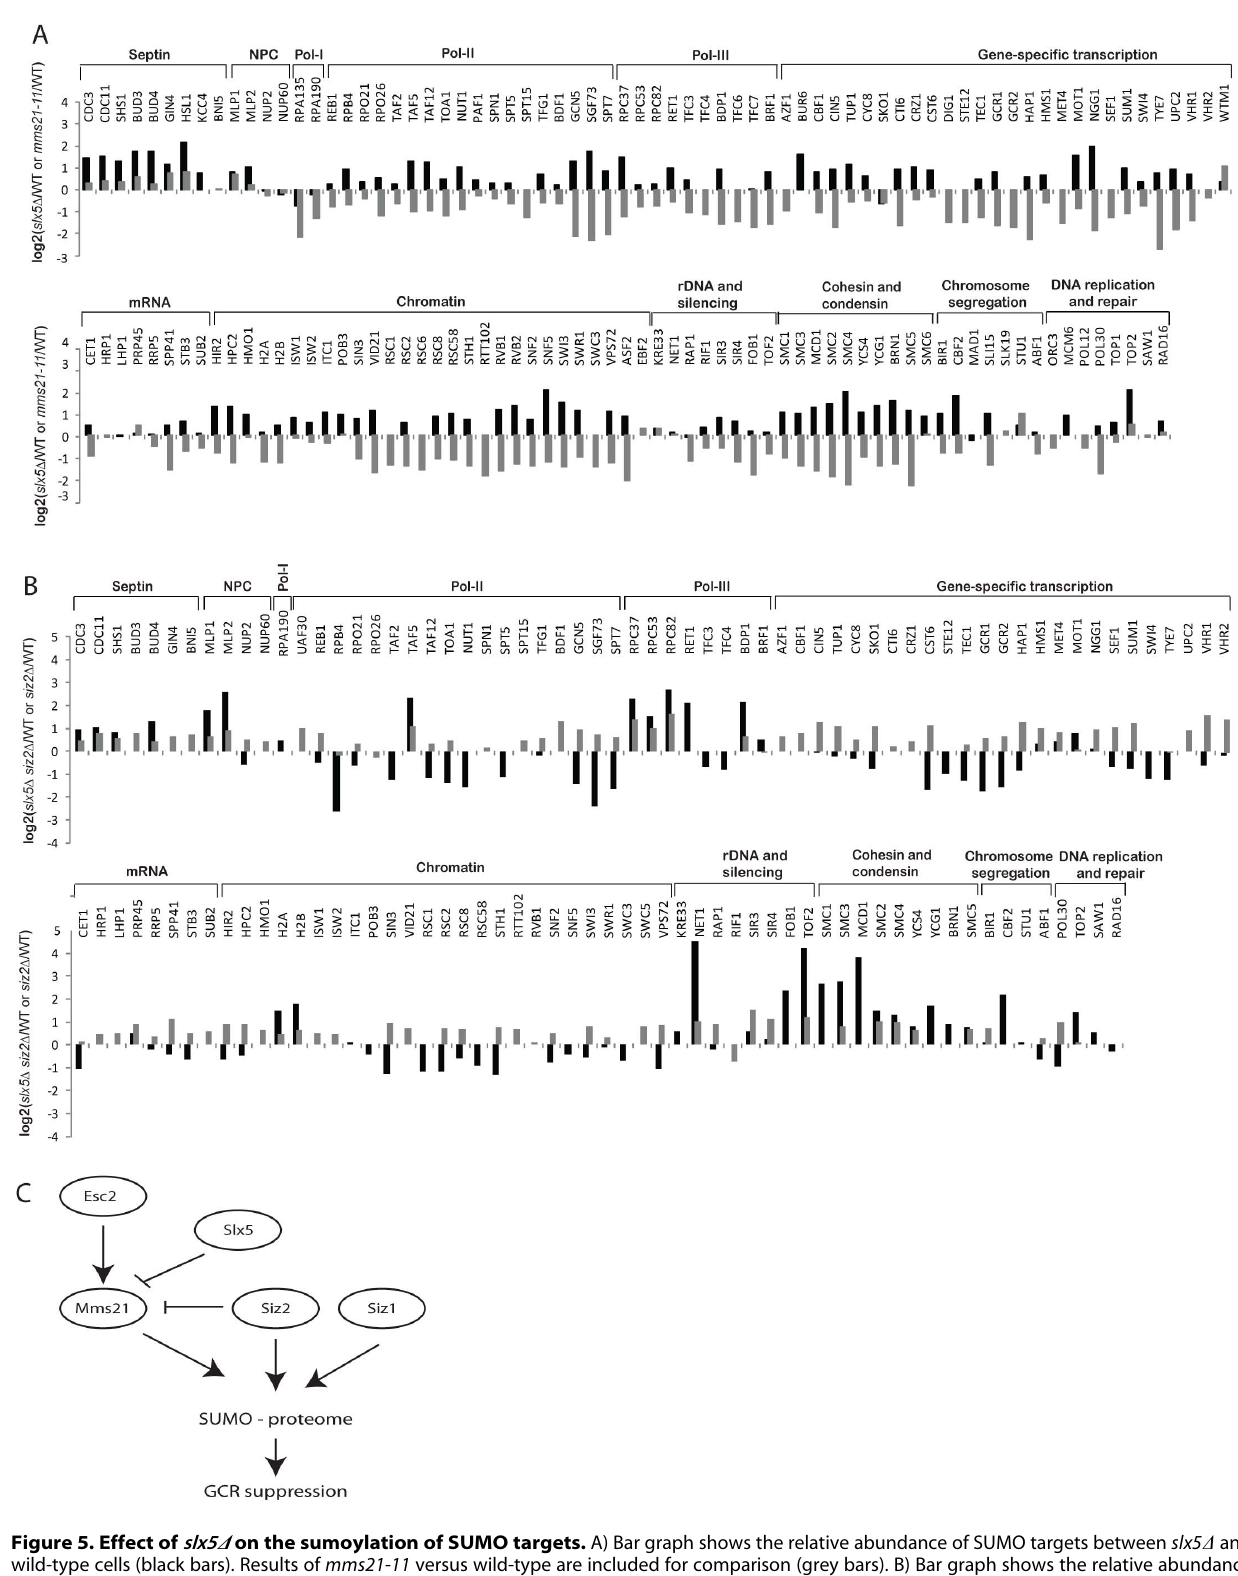
Figure 5. Effect of slx5 D on the sumoylation of SUMO targets. A) Bar graph shows the relative abundance of SUMO targets between slx5 D and wild-type cells (black bars). Results of mms21-11 versus wild-type are included for comparison (grey bars). B) Bar graph shows the relative abundance of SUMO targets between slx5 D siz2 D and wild-type cells (black bars). Results of siz2 D versus wild-type are included for comparison (grey bars). C) A proposed model of the regulation of sumoylation homeostasis in cells. Mms21-specific sumoylation is positively regulated by Esc2 and negatively regulated by Slx5 to achieve a balance of sumoylation in cells, which is critical to suppress GCRs.